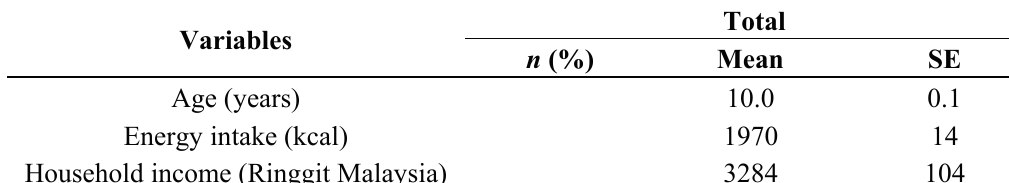
Table 1. Socio-demographic characteristics and energy intake of